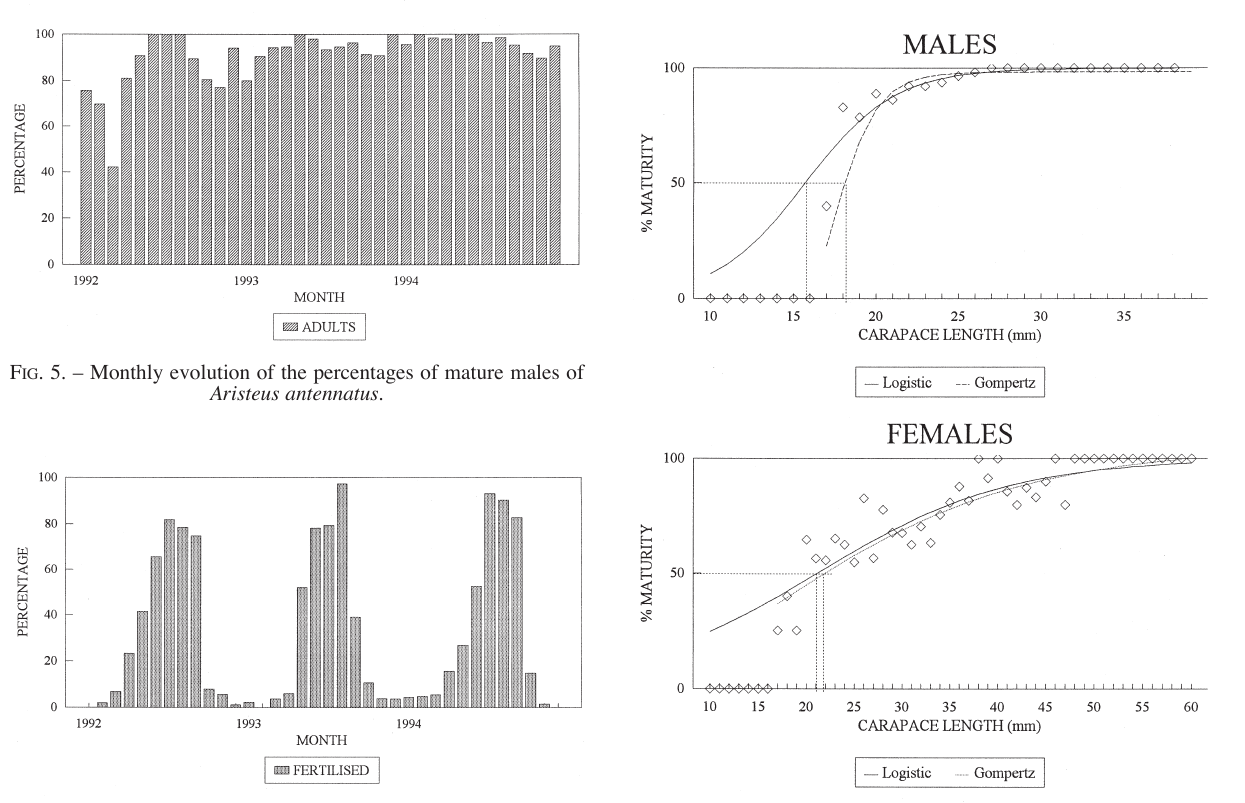
F IG . 6. – Monthly evolution of the percentages of mated (with sper- matophora) females of Aristeus antennatus .